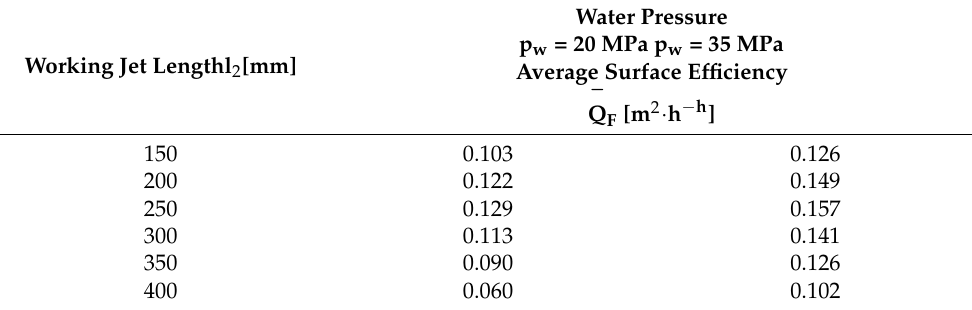
Table 15. Measuring results of average surface paint coat stripping efficiency Q F [m 2 · h − 1 ] from the surface of specimen made of X5CrNi18-10 steel depending on jet working length l 2 [mm].